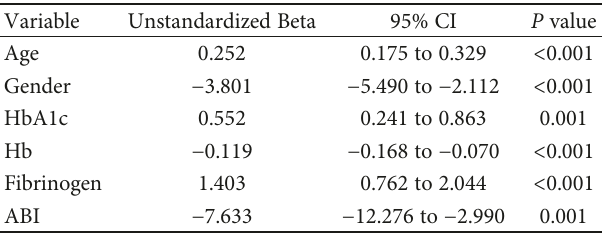
Table 4: Multiple stepwise regression analysis of VPT value in all T2DM patients.